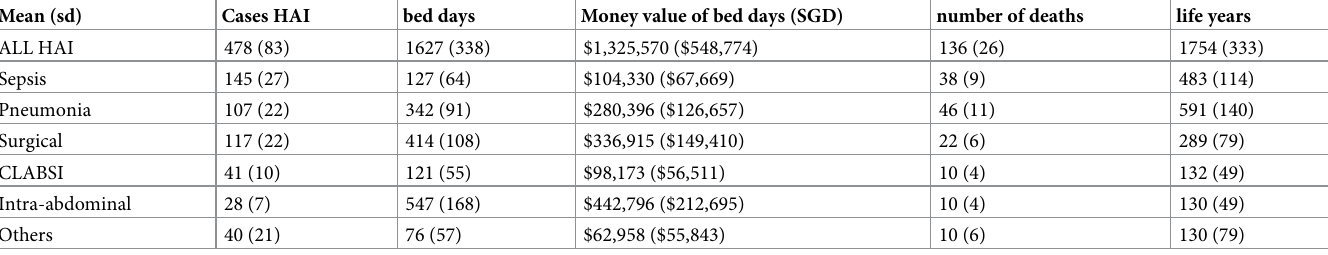
Table 3. Changes to outcomes from a decision to adopt a temporary isolation rooms, per 100,000 occupied bed days. Mean (sd) Cases